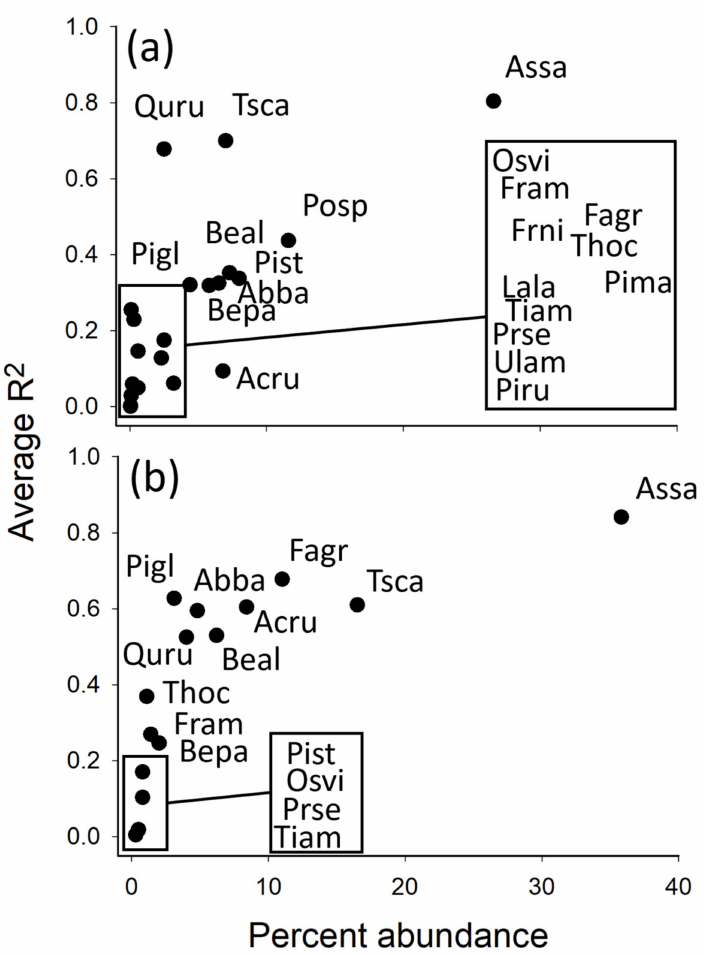
Figure 7. Average Sentinel-based model R 2 values plotted against species abundances from corre- sponding field test datasets in Haliburton Forest, Ontario (( a ) = percent basal area of stems ≥ 10 cm DBH in 155 0.25-ha plots; ( b ) = percent basal area of stems ≥ 10 cm DBH in 51 0.24-ha plots in the Megaplot). Models in ( a ) were trained using the forest resource inventory (Sentinel-FRI; see Table 1) and in ( b ) using field data (Sentinel-field; see Table 2). R 2 values for RF and CNN models were averaged. Species acronyms are the first two letters of the genus and